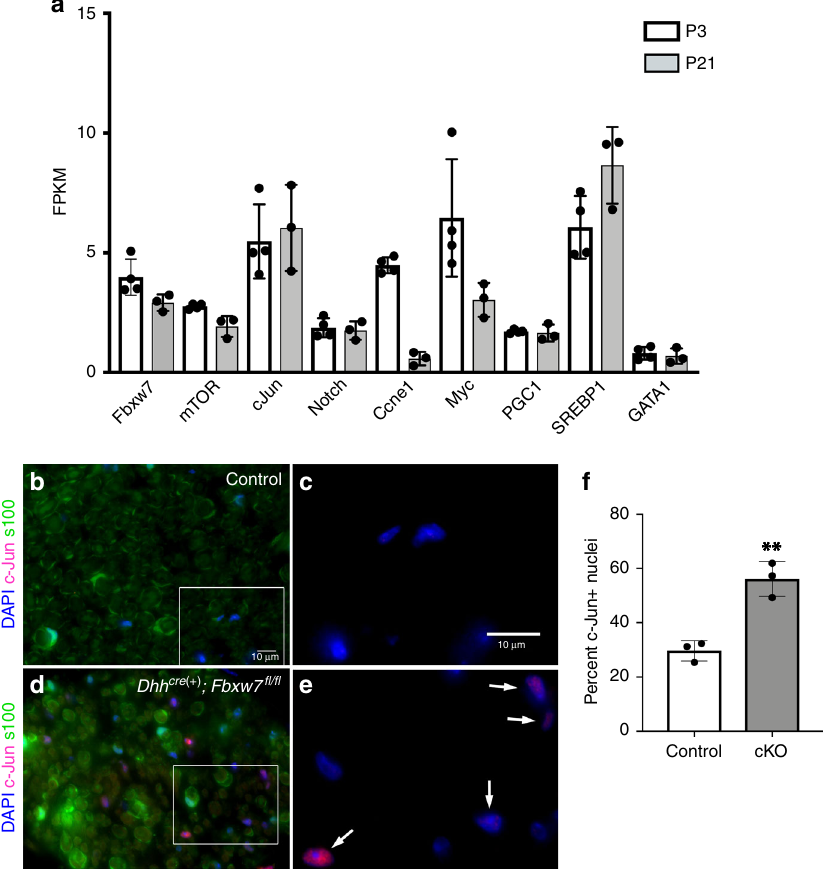
Fig. 6 c-Jun is elevated in Fbxw7 mutant nerves. Previously published RNAseq data 24 from WT sciatic nerves at P3 and P21 was mined to reveal that, in addition to Fbxw7 itself and mTOR , several other well-known targets of Fbxw7 are expressed during SC development ( a ). Immuno fl uorescence studies of control ( b , c ) and Dhh cre ( + ) ;Fbxw7 fl / fl ( d , e ; white arrows indicate c-Jun positive nuclei; cKO) nerves at 6 months. cKO nerves display nearly three times the proportion of c-Jun + nuclei relative to controls ( f ; p = 0.0025 (**), unpaired t -test with Welch ’ s correction). N = 3 per genotype. Error bars depict